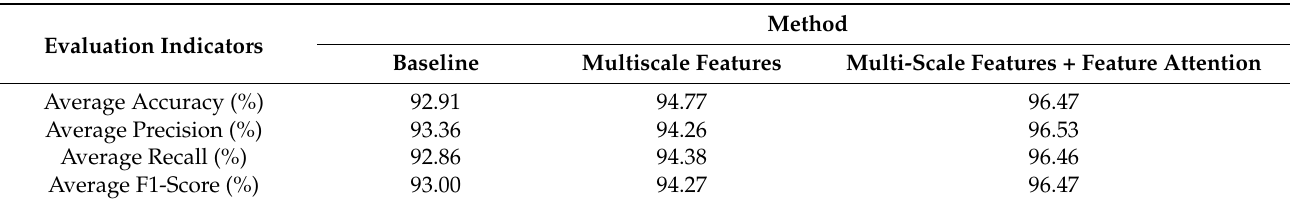
Table 6. Indicators of ablation experiments.